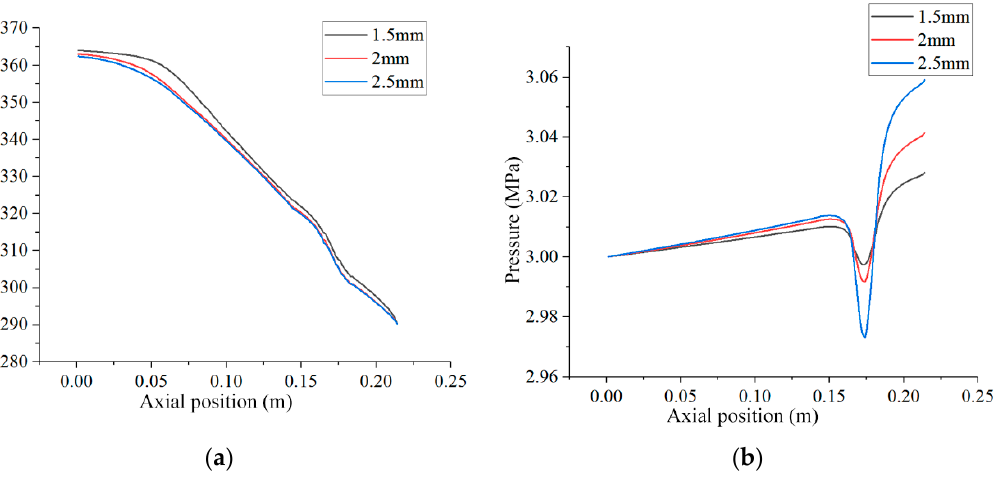
Figure 21. Temperature and pressure along the course of coolant with different rib widths.